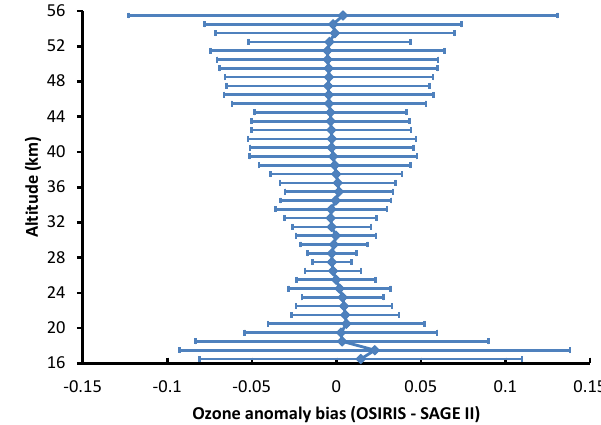
Fig. 1. Anomaly bias between the two sensors at the Equator ( ± 4.5 ◦ latitude) determined from averaging monthly ozone anomalies in the overlap period (2001–2005). The mean bias is 0.00 ± 0.005 (1 σ) over the 16 to 56km range. The error bar represents the standard deviation of the anomaly differences in the overlap period and re- flects the seasonal variability of the anomaly bias in the lower strato-